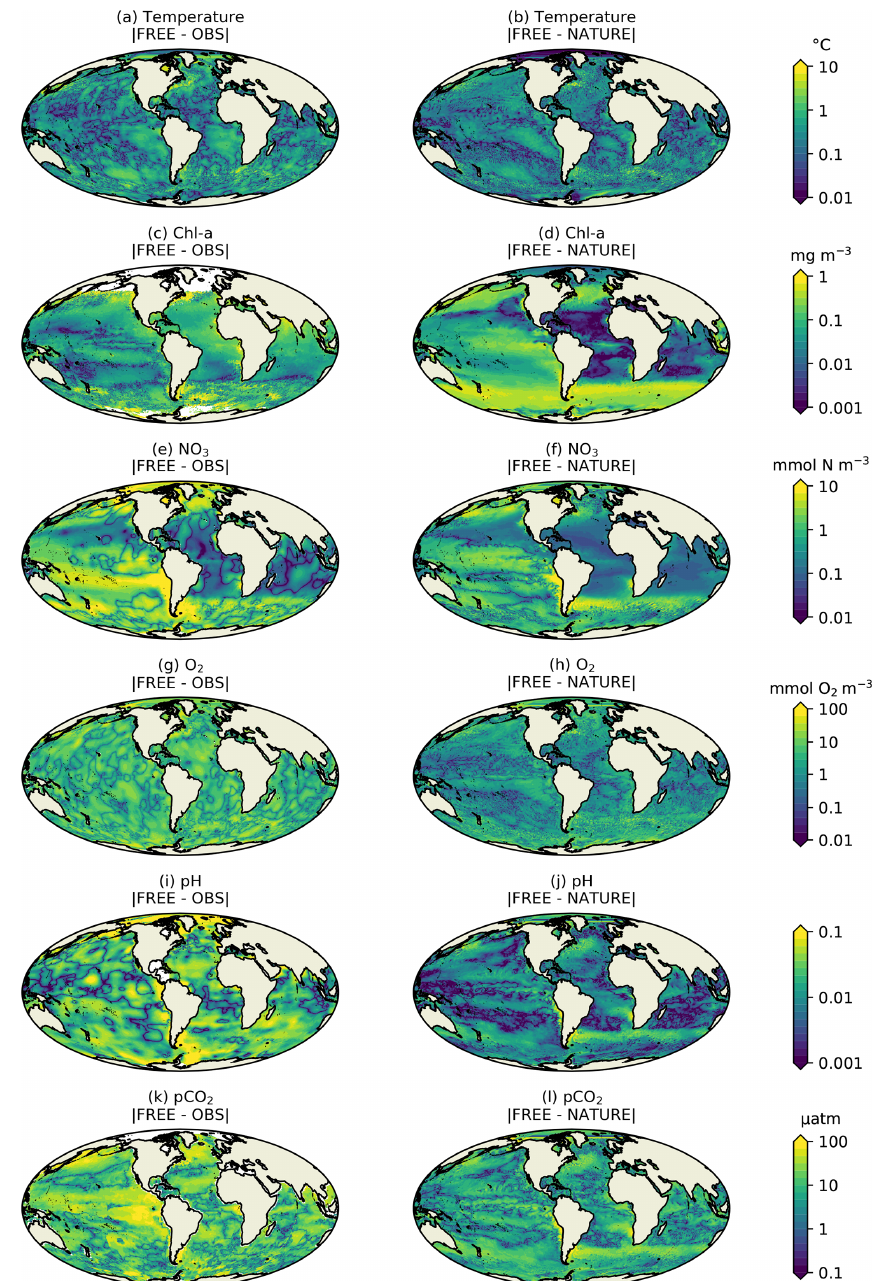
Figure 3. Absolute difference for December 2009 for surface (a, b) temperature, (c, d) Chl a , (e, f) NO 3 , (g–h) O 2 , (i, j) pH, and (k, l) p CO 2 between FREE and real-world observation-based products (left column), as well as between FREE and NATURE (right